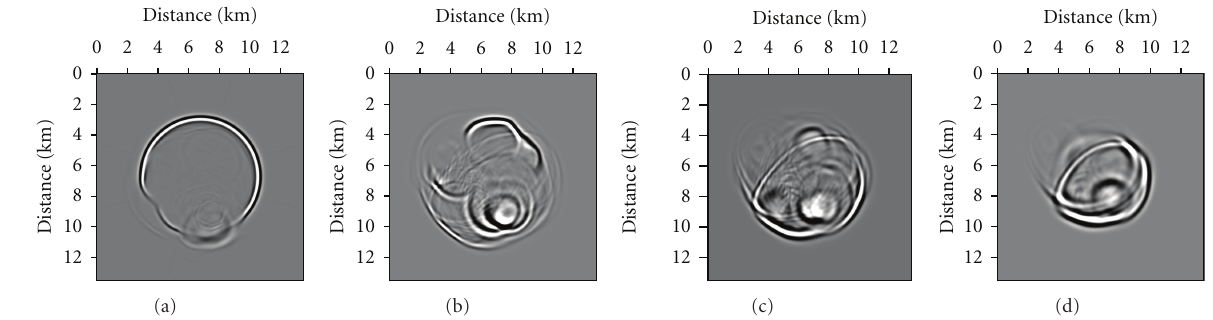
Figure 8: Impulse response of FFD migration with alternating four-way splitting. Horizontal cuts as in Figure 4.